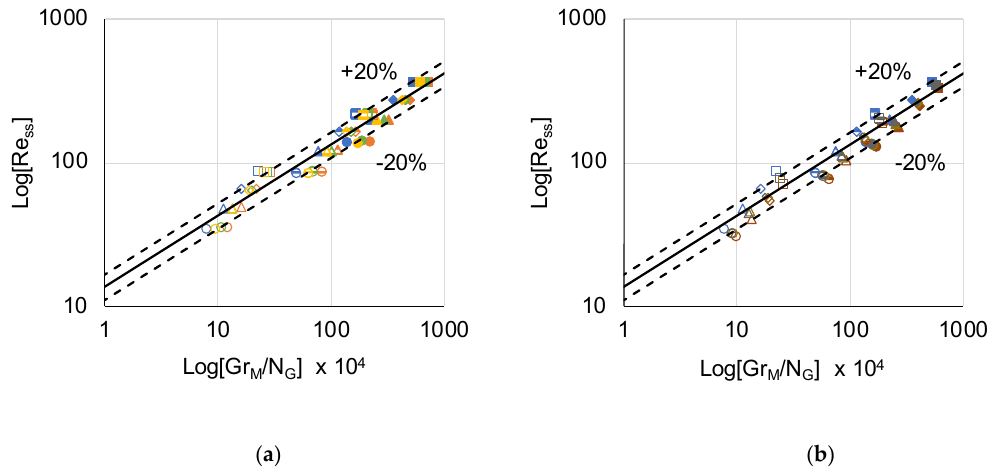
Figure 8. Concentration dependent Re ss model for nanofluid based SPNCmLs for ( a ) MTP and ( b ) PTP.